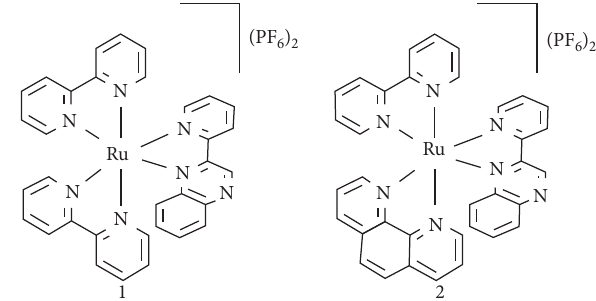
Scheme 1: Chemical structures of complexes under study in this work (complexes 1 and